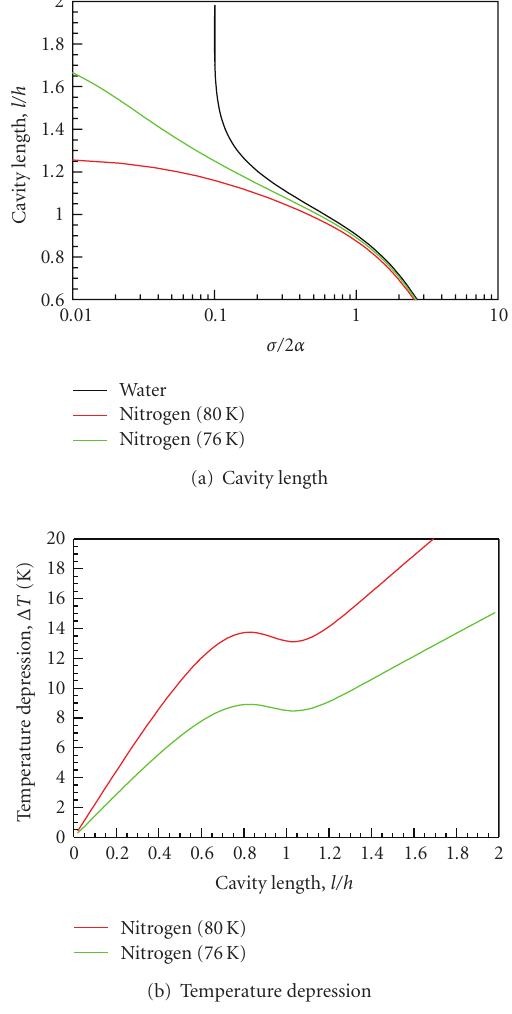
Figure 6: Numerical results in the case of LN2 and cold